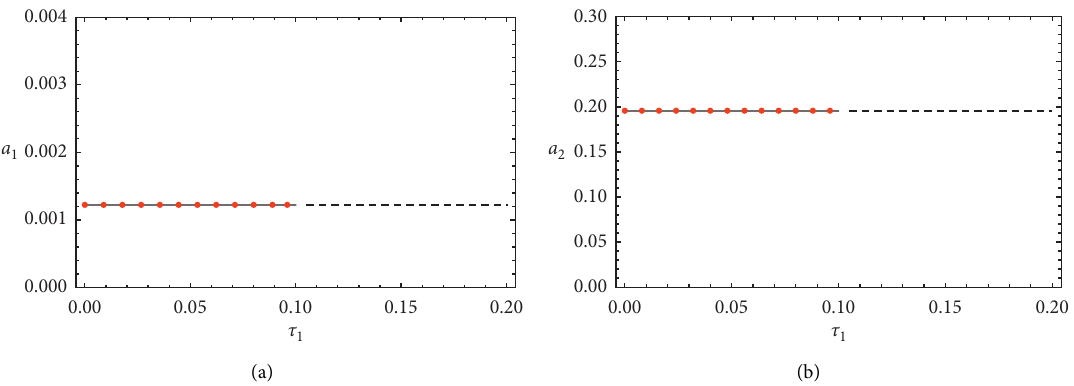
Figure 2: Comparison of time delay τ � 0 ,y � 0 . 07 , α � 3 , c � 3 , ζ � 0 . 001 , and σ τ 2 0